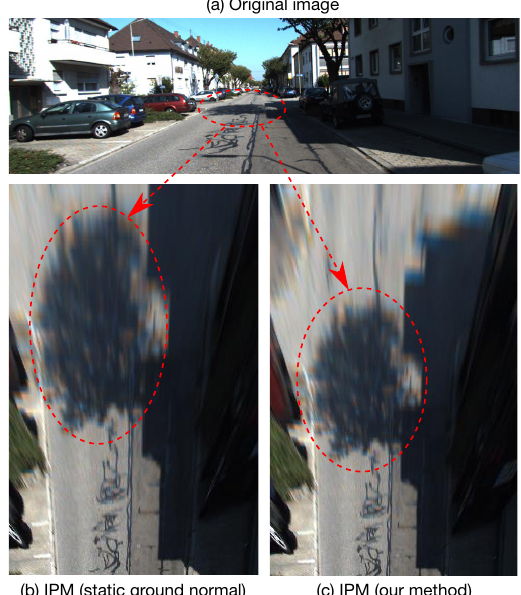
Figure 2. Comparison of IPM images before and after using our proposed method. ( a ) Original image from KITTI odometry dataset. ( b ) IPM image using fixed extrinsic from the camera to the ground. ( c ) IPM image using the dynamic extrinsic calculated by our proposed methods. It can be clearly observed that the image in ( c ) is more accurate. See our supplementary video for better